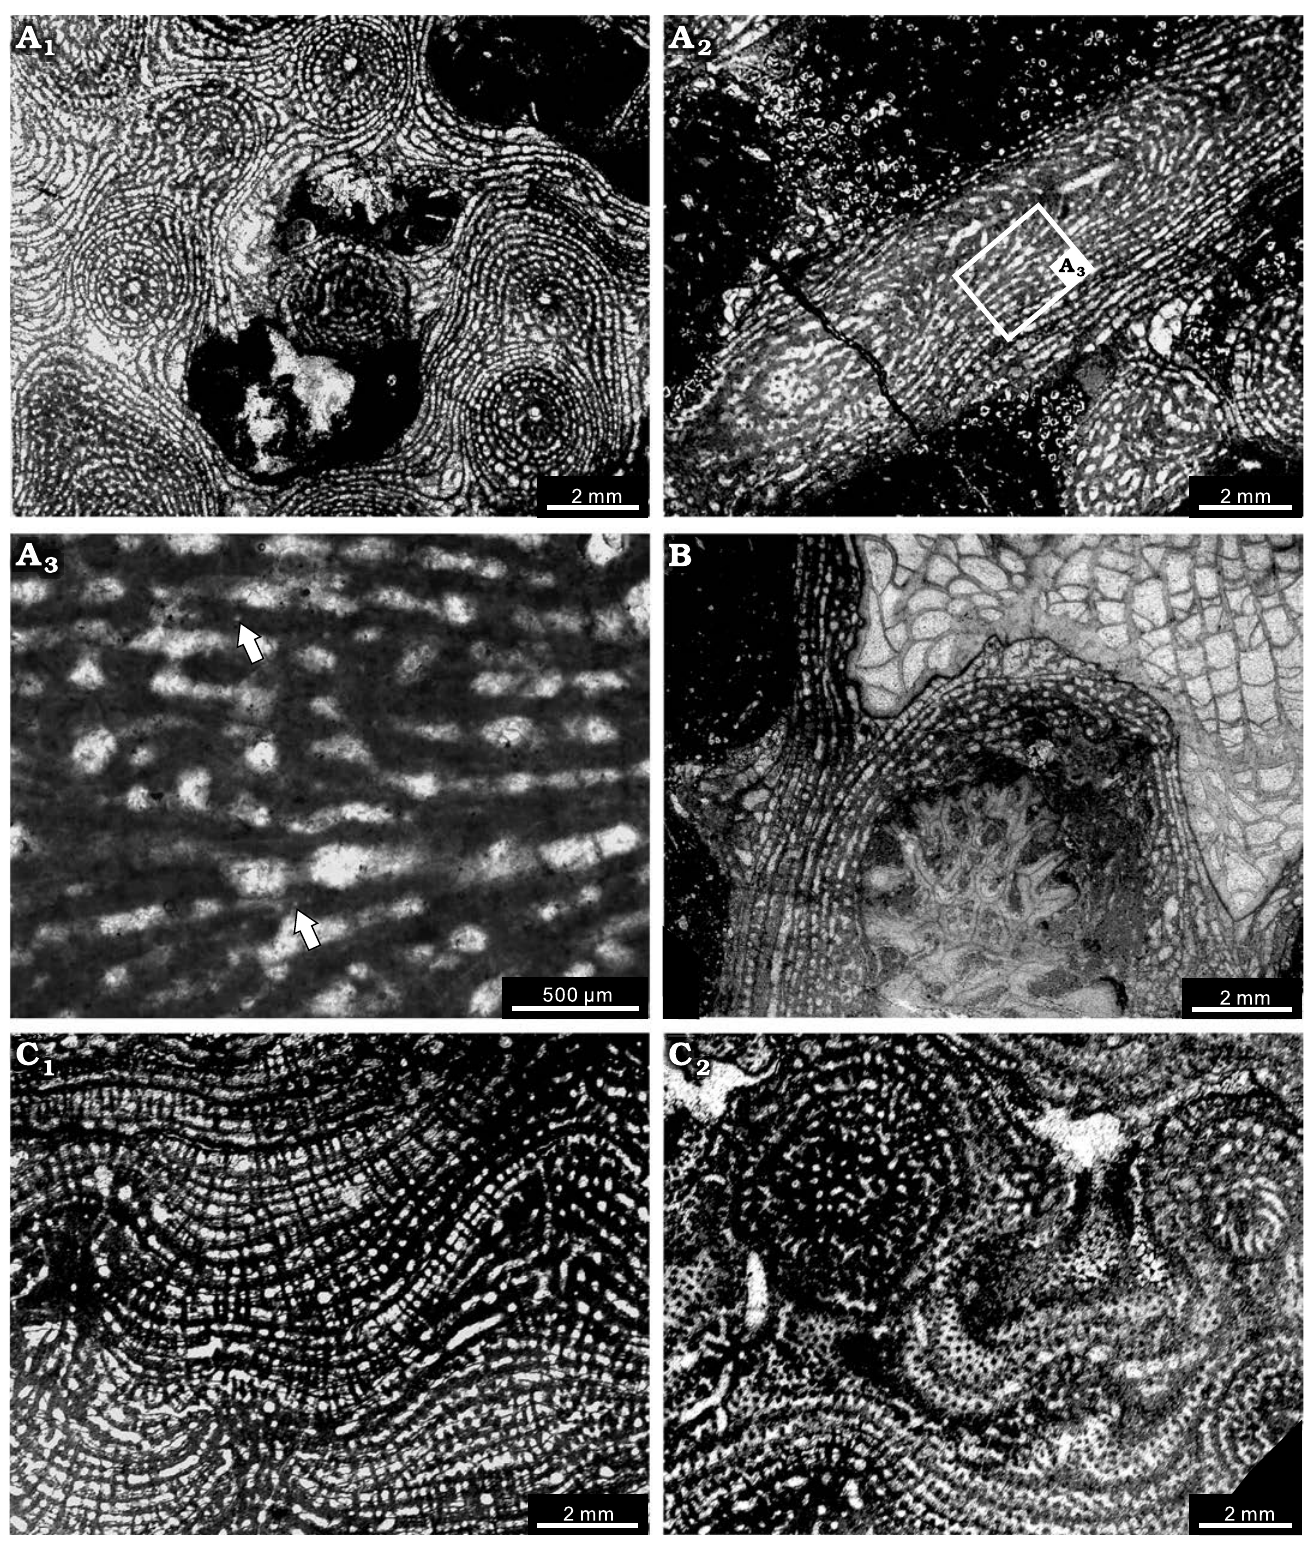
Fig. 7. Stromatoporoids from the Jiwozhai reef, Jiwozhai Member, Dushan Formation, Givetian, Middle Devonian; Dushan, Guizhou, South China . A , B . Stictostroma saginatum (Lecompte, 1951) A . NIGP 177050; A 1 , tangential section showing the isolated pillars and locally irregular skeleton; A 2 , longitudinal section, note the prominently vertically erected mamelon; A 3 , enlargement of A 2 , note the coarsely ordinicellular microstructure (arrows). B . NIGP 177051; longitudinal section, note the encrusting skeleton over Thamnopora sp. debris and a solitary rugose coral. C . Synthetostroma actinos­ tromoides Lecompte, 1951, NIGP 177052; C 1 , longitudinal section; C 2 , tangential